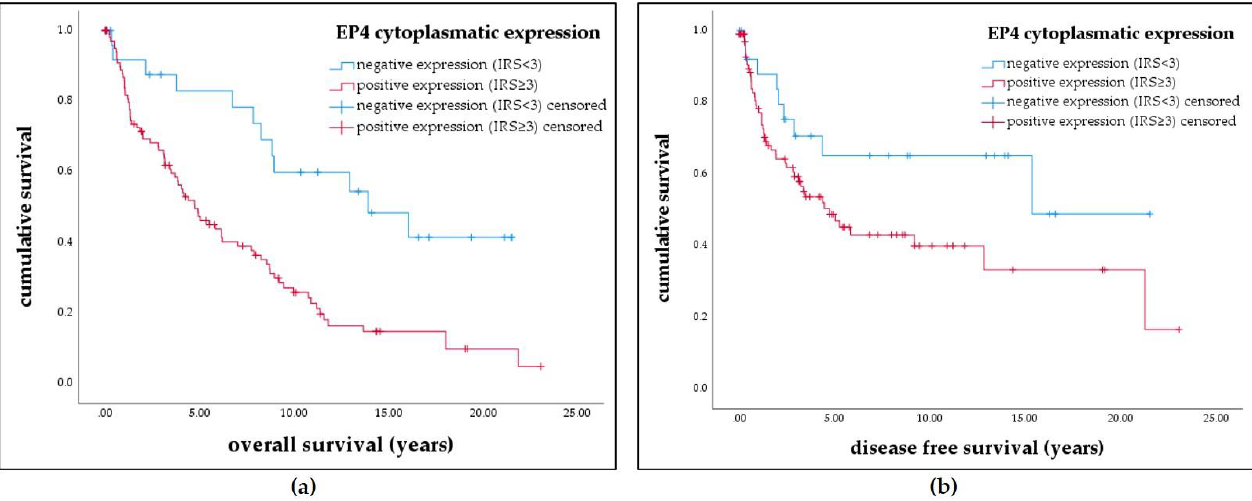
Figure 2. Kaplan–Meier estimates show that overall survival/disease-free survival is worse in patients with high EP4 expression. ( a ) Kaplan–Meier survival univariate analysis for the status cytoplasmatic IRS ≥ 3. Positive expression of EP4 in the cytoplasm significantly reduced overall survival ( p = 0.001) ( b ) Kaplan–Meier survival univariate analysis for the status cytoplasmatic IRS ≥ 3. Positive expression of EP4 lead to decreased disease-free survival ( p = 0.069). Table 2. Cox regression of clinicopathological variables regarding overall